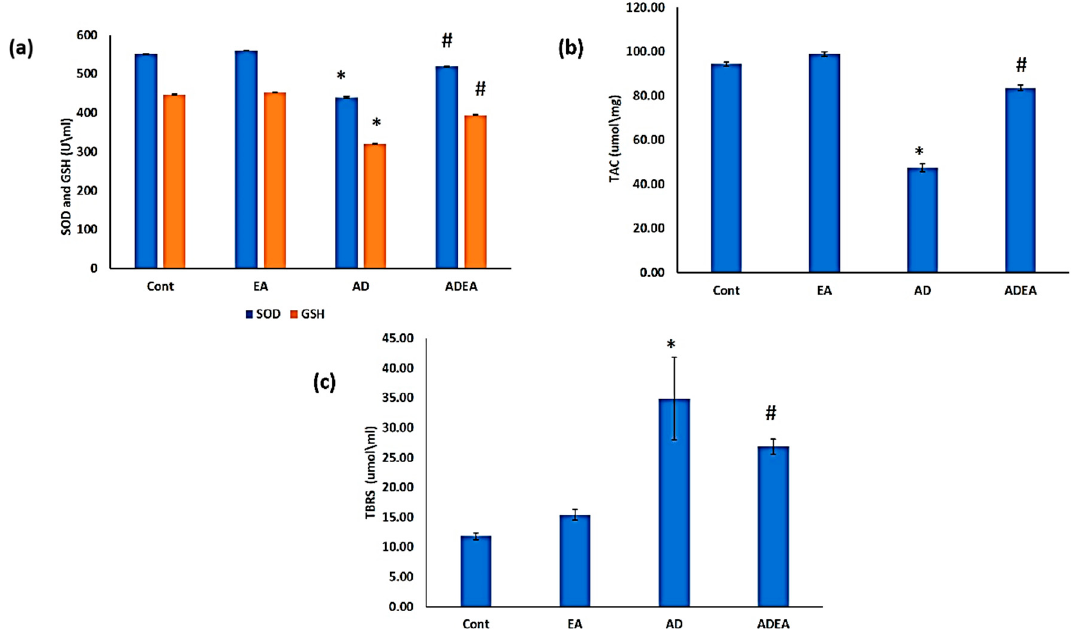
Figure 1. ( a – c ): Novel object recognition test. ( a ) A schematic diagram representing the stages of the NORT; ( b ) bar graph showing familiar and novel object exploration times spent by rats in all groups; ( c ) bar graph showing the DI between familiar and novel objects. Data are presented as the means ± SD. One-way ANOVA was used, and Fisher’s LSD t -test was applied when equal variance could be assumed. * Significantly different from the control, EA, and ADEA groups at p ≤ 0.05. # Significantly different from the AD group at p ≤ 0.05.